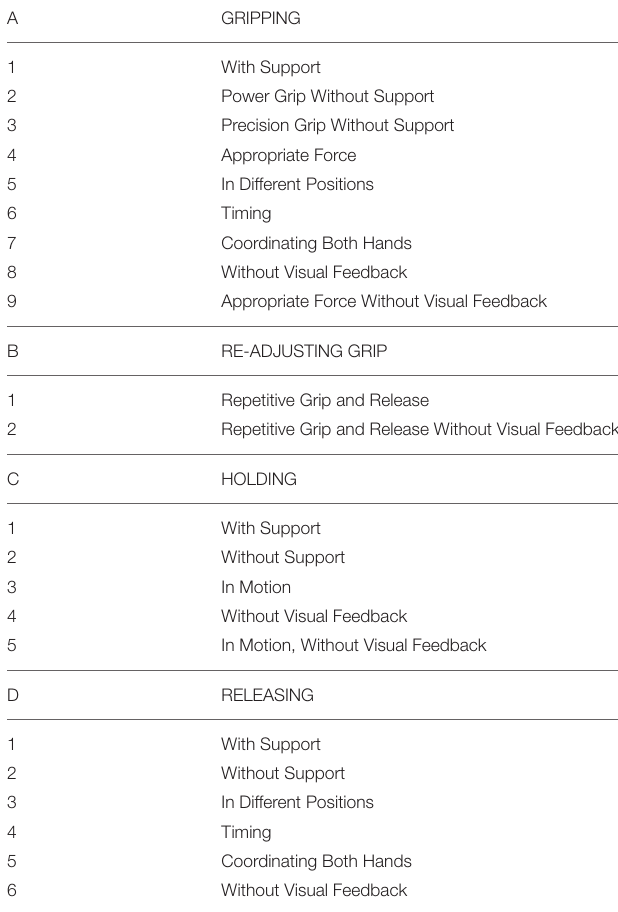
TABLE 8 | Description of the 22 items evaluated by